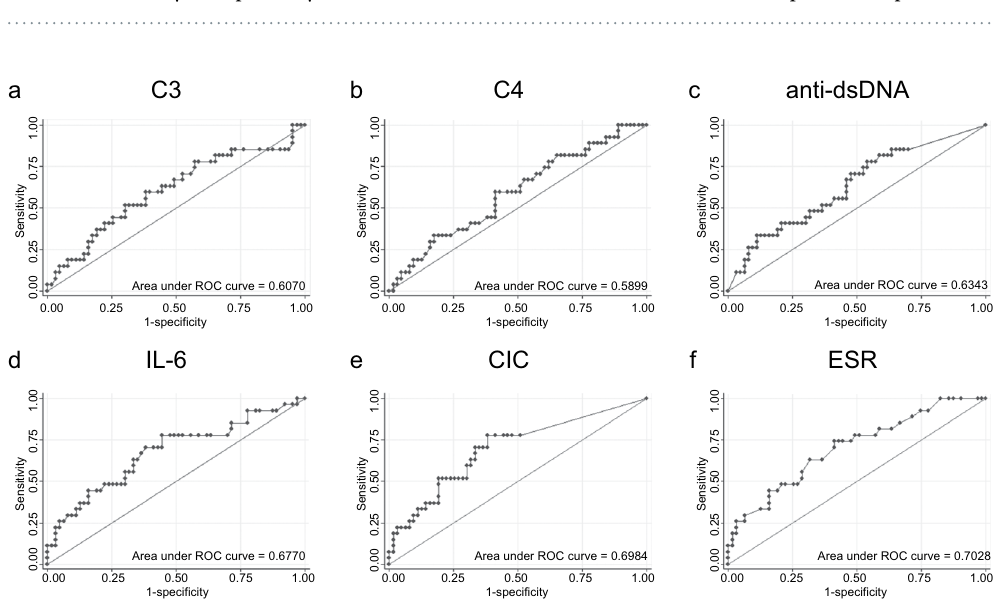
Table 5. Sensitivity and specificity of biomarker models in the active clinical SLEDAI. * p < 0.05, ** p <